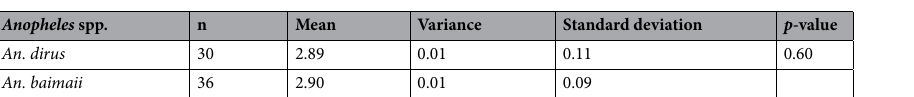
Table 3. Mean wing centroid size of Anopheles dirus and An. baimaii, and statistical characteristics .